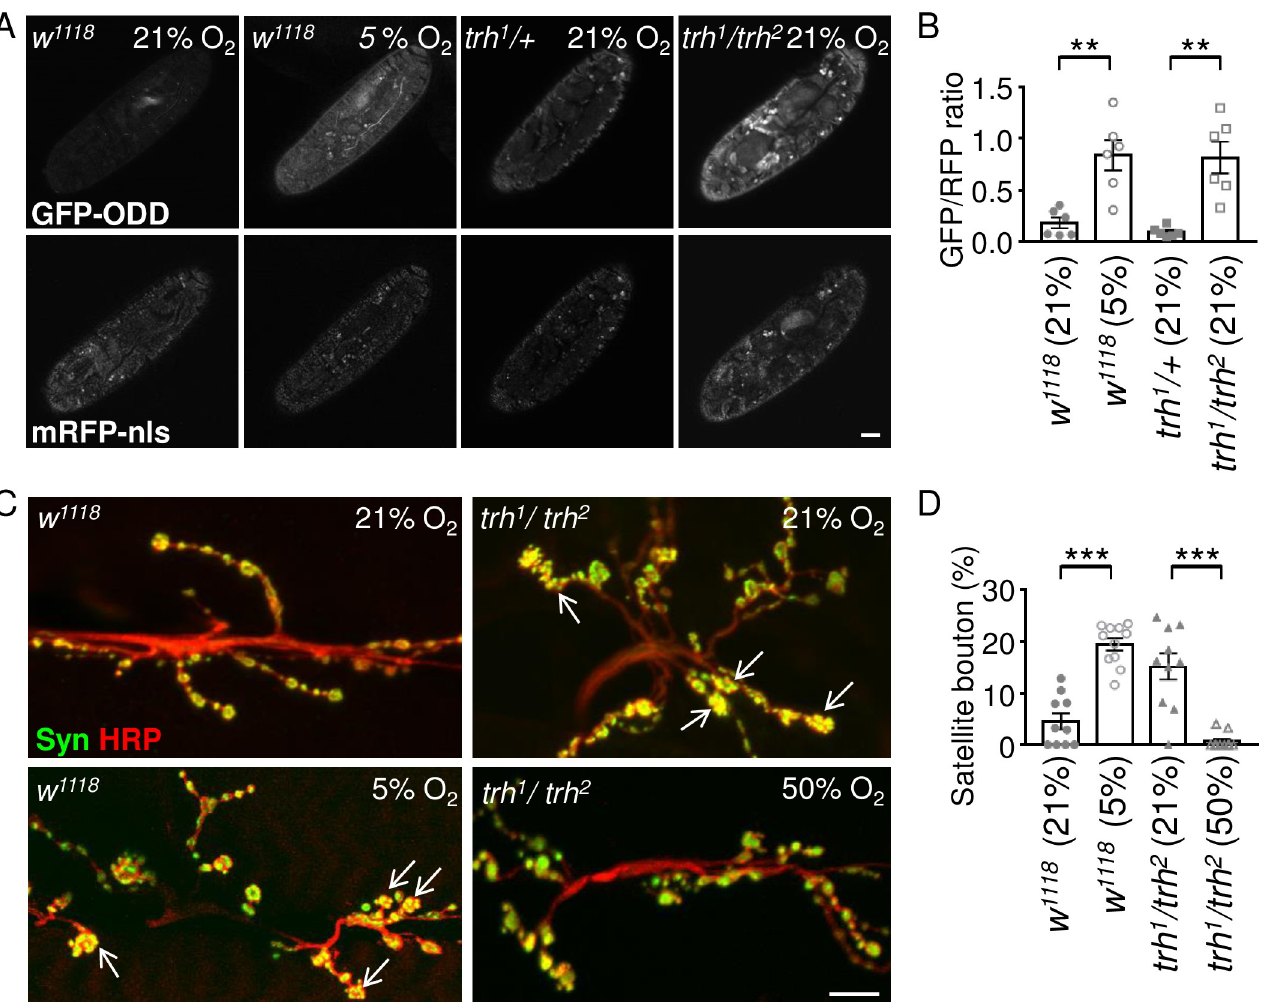
Fig 2. Induction of satellite boutons in trh mutant by hypoxia. (A) Images of late-stage embryos of w 1118 , trh 1 /+ , and trh 1 /trh 2 carrying the GFP-ODD reporter (top row) and mRFP-nls control (bottom row) under normoxia (21% O 2 ) or hypoxia (5% O 2 ). Scale bar represents 40 μ m. (C) Images of NMJs from muscle 6/7 immunostained for Syn (green) and HRP (red) from w 1118 in 21% or 5% O 2 (left panels) and trh 1 /trh 2 in 21% or 50% O 2 (right panels). White arrows indicate clusters of satellite boutons. Scale bar represents 10 μ m. (B, D) Bar graphs show averages of the GFP/RFP immunofluorescence intensity ratios (B), or percentages of satellite boutons to total boutons (D). Statistical significance assayed by Mann-Whitney test is shown ( �� , p < 0.01; ��� , p < 0.001).